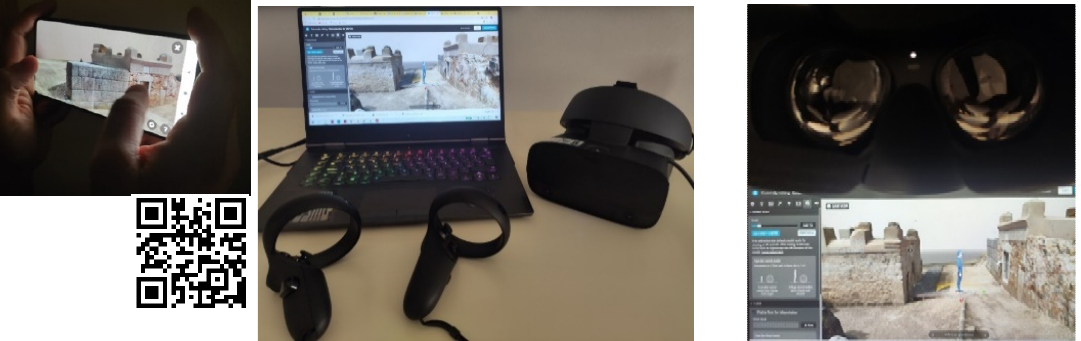
Figure 28. QR code to scan and be able to make a virtual visit to the monument. Augmented Reality (AR) through a mobile phone. Use of Virtual Reality glasses to enter the interior of funerary build- ings.